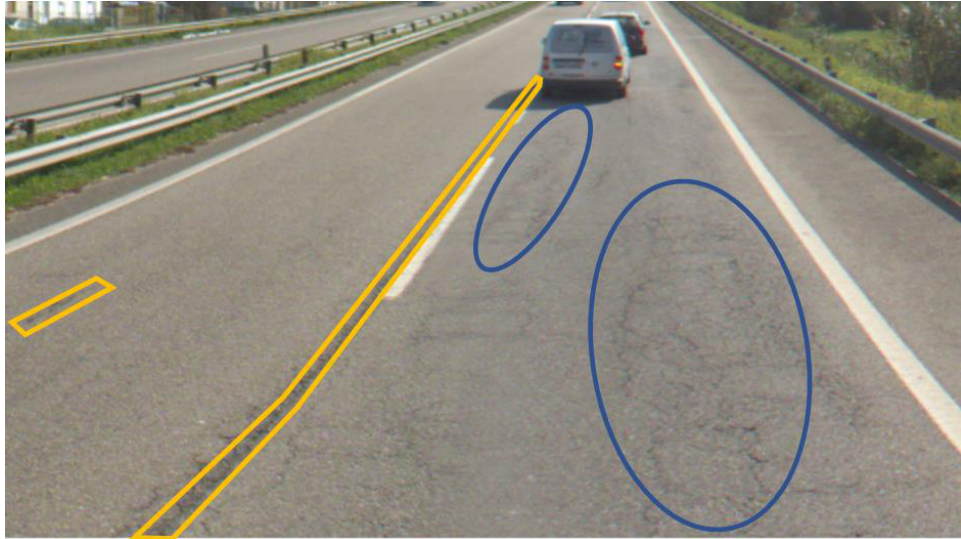
Figure 12. Road spot 2. Ladybug camera image with delimited cracked areas.